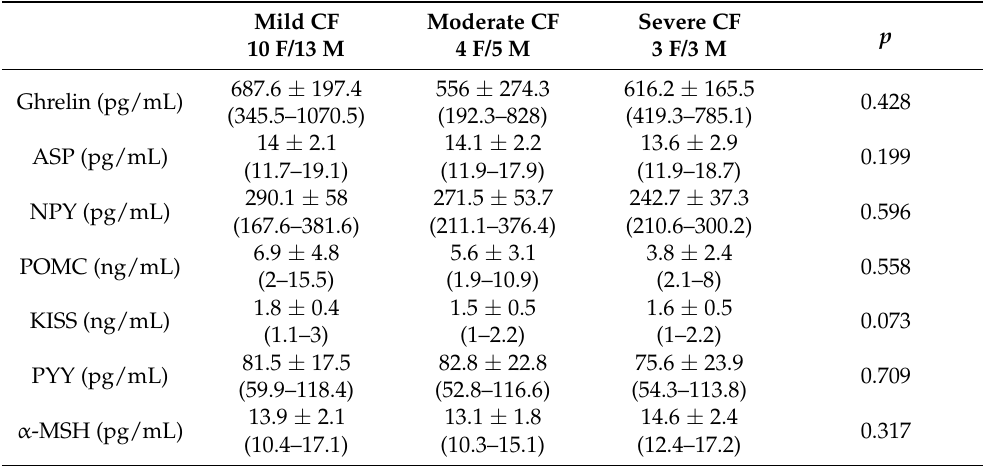
Table 2. Levels of hormones depending on the disease severity